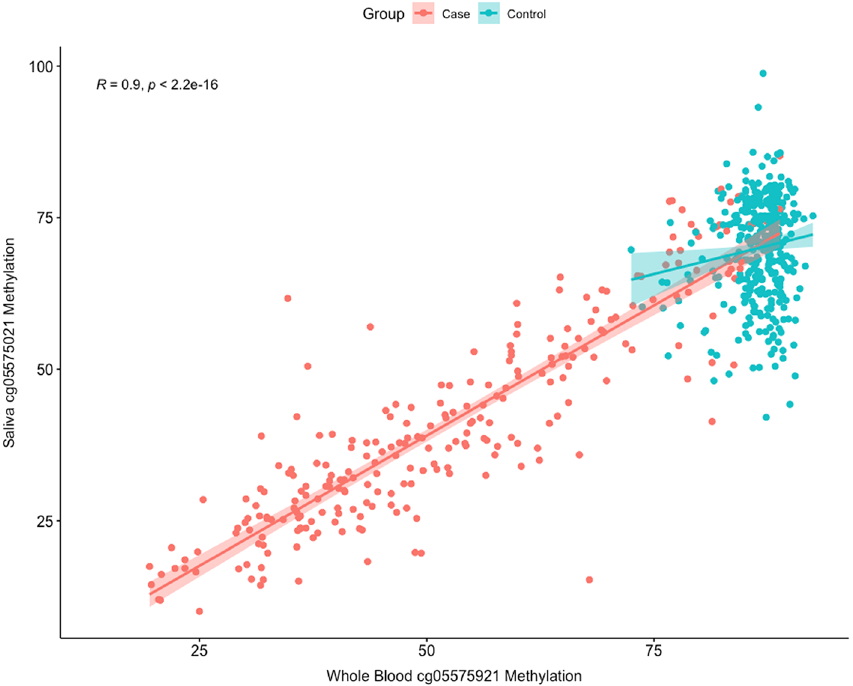
Figure 6. The relationship of WB cg05575921 methylation to saliva cg05575921 methylation. The salmon colored line represents the best fit line for the smoking subjects while the blue line represents the best fit line for the non-smoking